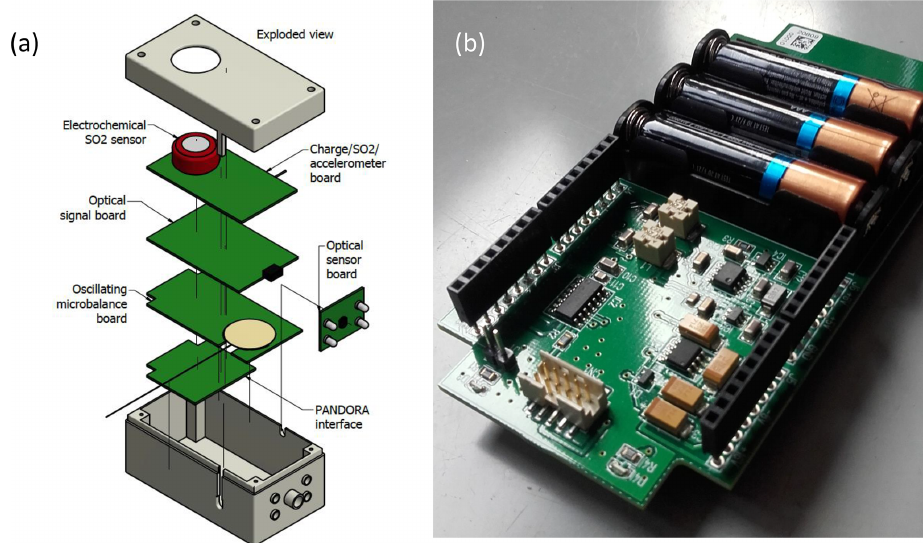
Figure 7. The PANDORA4 system for support of additional radiosonde sensors. (a) Stackable arrangement of multiple sensor boards, in this example including an accelerometer, collecting wire for an oscillating microbalance, cloud, charge and gas detectors. (b) PANDORA4 data board for use with RS41 radiosonde, showing stackable connectors and additional battery